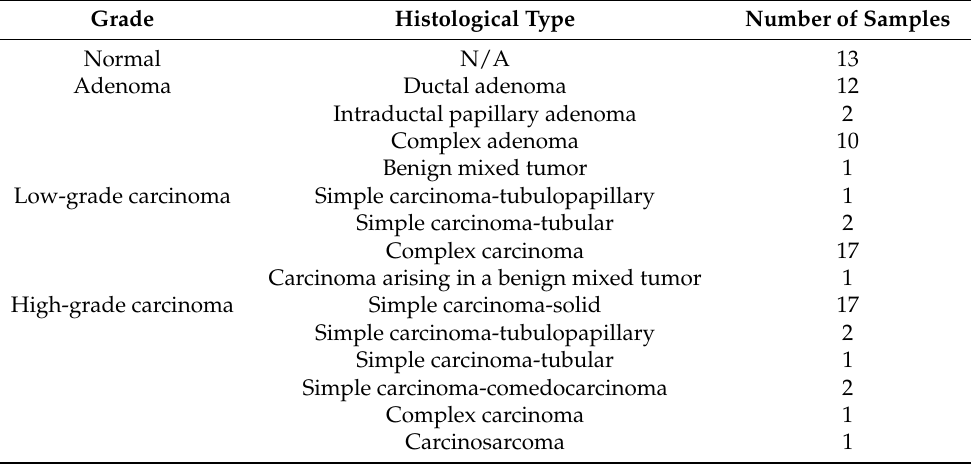
Table 1. Histopathological features of tissues samples.